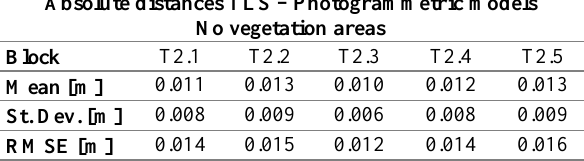
photogrammetric models without areas of vegetation.